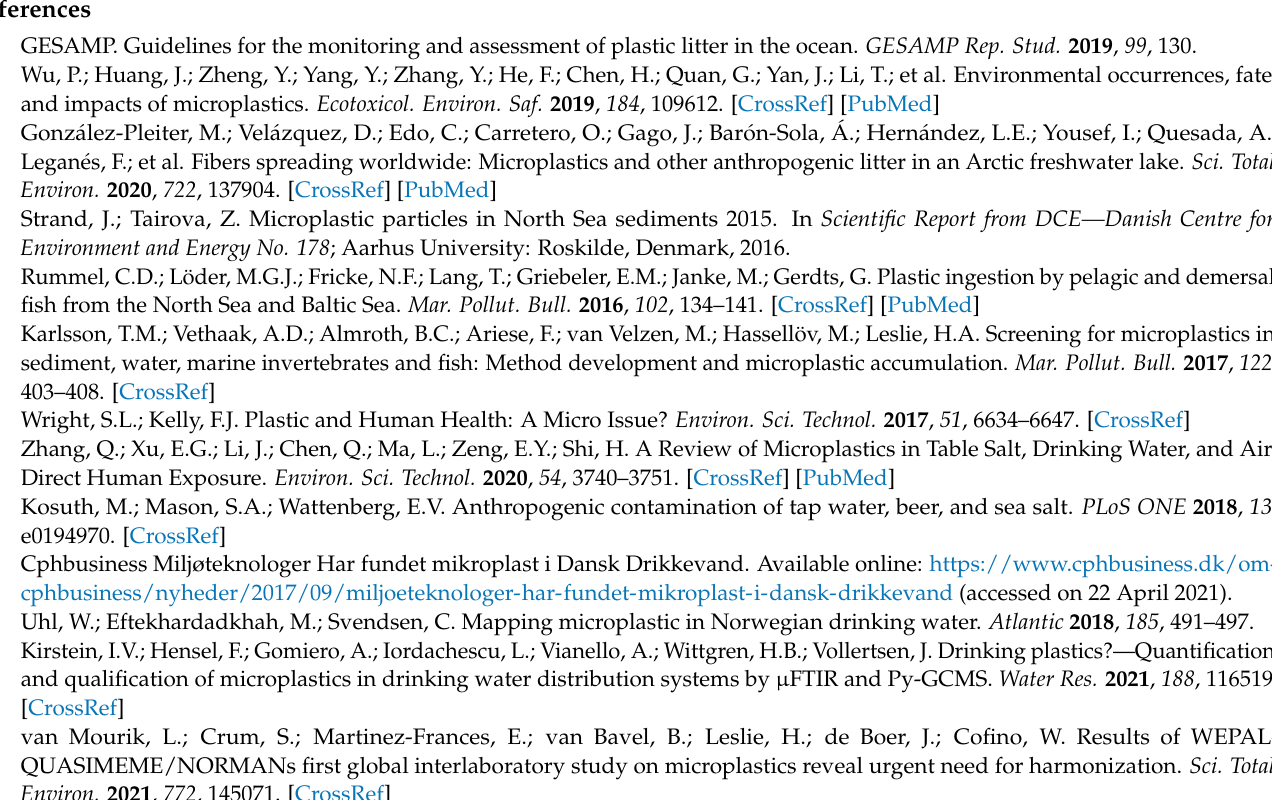
Table S1: Description of sampling sites, Table S2: Quantification of MP-like particles > 100 µ m in blank samples, Table S3: Quantification of MP-like particles > 100 µ m in 50 L tap water